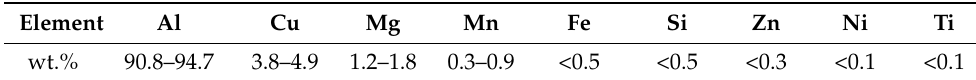
Table 4. Chemical content of 2024 (D16)